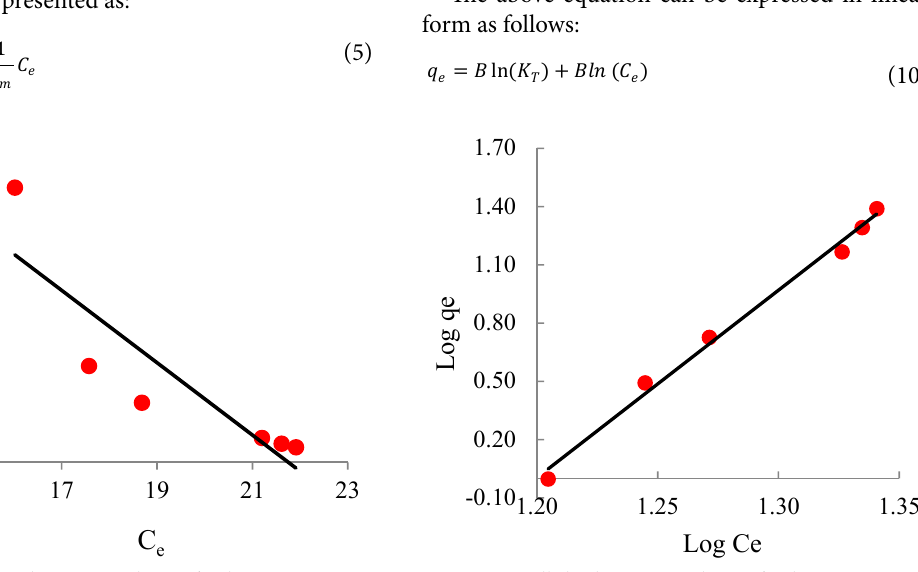
Fig. 10: Freundlich adsorption isotherm of cadmium ions onto polypyrrole/titanium dioxide